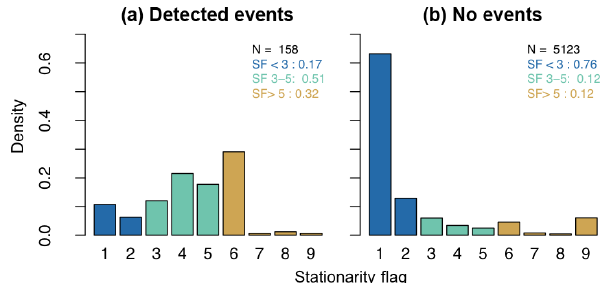
Figure 3. Stationarity flag frequency distribution of half-hourly timestamps, separating between fluxes that were influenced by events (a) and those where no events were detected (b) . Station- arity flags were grouped into the three classes: high (dark blue), medium (light blue) and low (light brown) stationarity. The total count of timestamps is slightly above the sum of timestamps avail- able during the study period (5280) due to an occasional occurrence of several events in a single half-hour